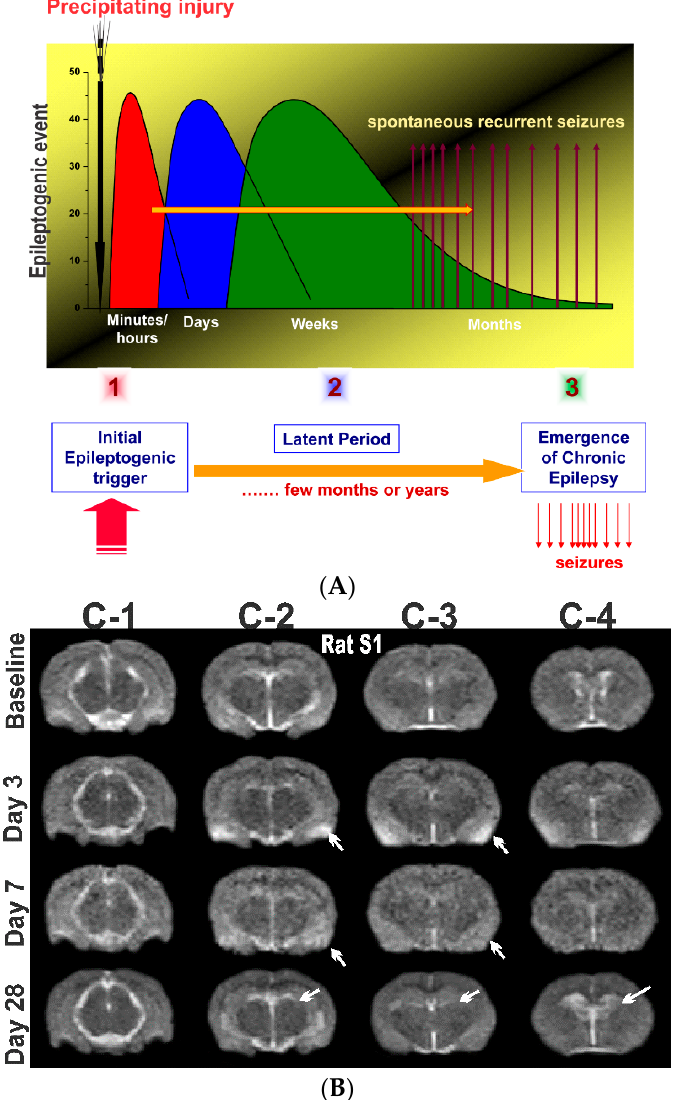
Figure 1. The process of epilepsy development and MRI biomarkers. ( A ) Epileptogenesis can be described in three progressive stages: (1) the initial injury (epileptogenic trigger); (2) the latent period (silent period with no seizures); and (3) chronic period with spontaneous recurrent seizures. The initial precipitating factor, such as brain injury, infections, stroke, and status epileptics, activates diverse signaling events, such as inflammation, oxidation, apoptosis, neurogenesis and synaptic plasticity, which eventually lead to structural and functional changes in neurons. These changes are eventually manifested as abnormal synchronized hyperexcitability and spontaneous seizures. ( B ) Representative MR images of brain before and after exposure to the organophosphate DFP in rats. T2-weighted coronal images showing the progressive changes in brain edema and damage at 3, 7 and 28 days post-DFP exposure. White arrows signify areas of pathological abnormalities. Overall, the hippocampus, limbic structures, and cortical regions show striking atrophy and lesions, while fluid expansion is evident in the lateral ventricles. C-1, C-2, C-3 and C-4 represents various coronal sections from rat brain. Animal use protocol was approved by the Institutional IACUC (#2017-0261) on 10/27/2017.